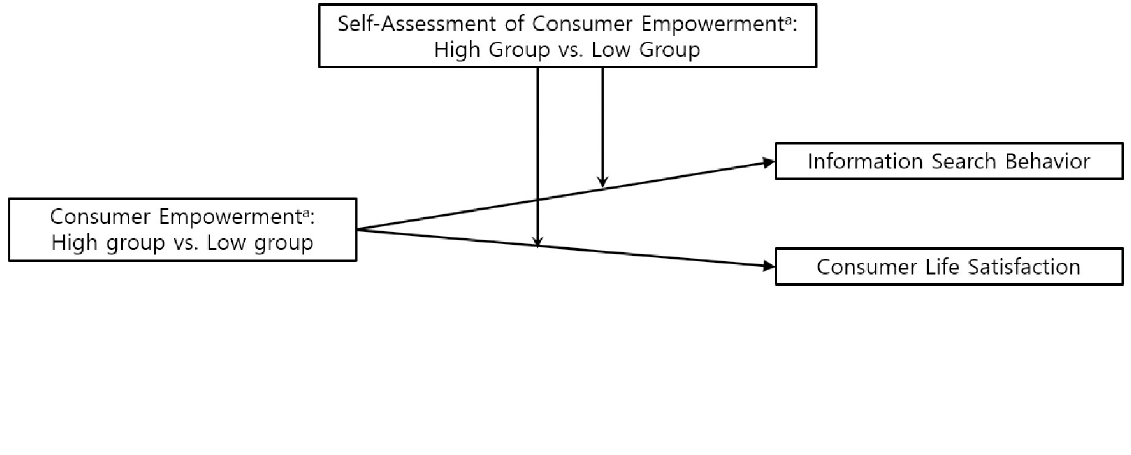
Fig 1. Conceptual